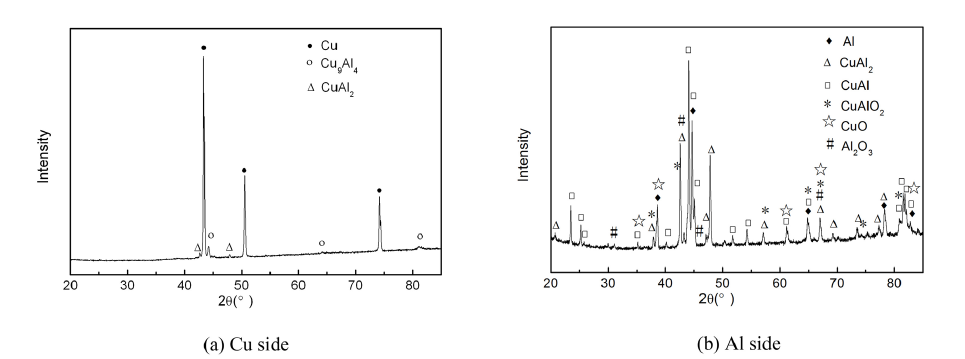
Figure 8. Microstructure and current map of flash welded Cu/Al joint after heat treatment at 350°C for 500h: (a) SEM; (b) CAFM analysis result in the red rectangle of SEM image.